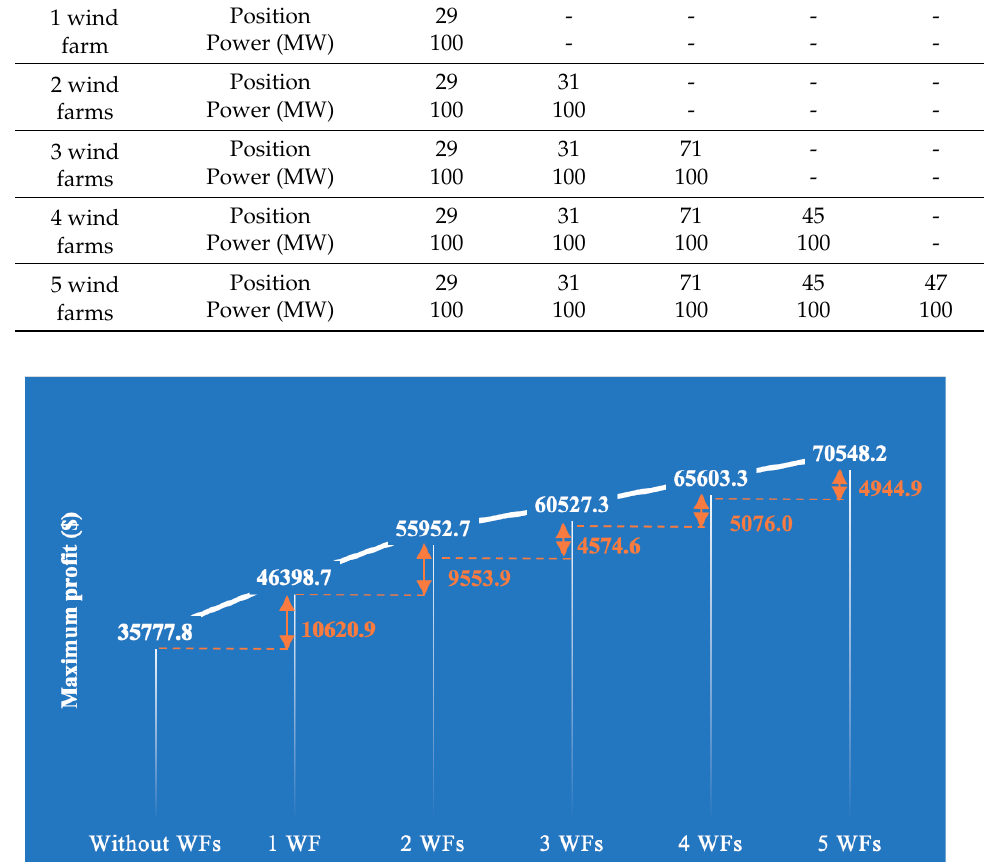
Figure 20. Comparison of profits from different cases of the IEEE 118-node system.